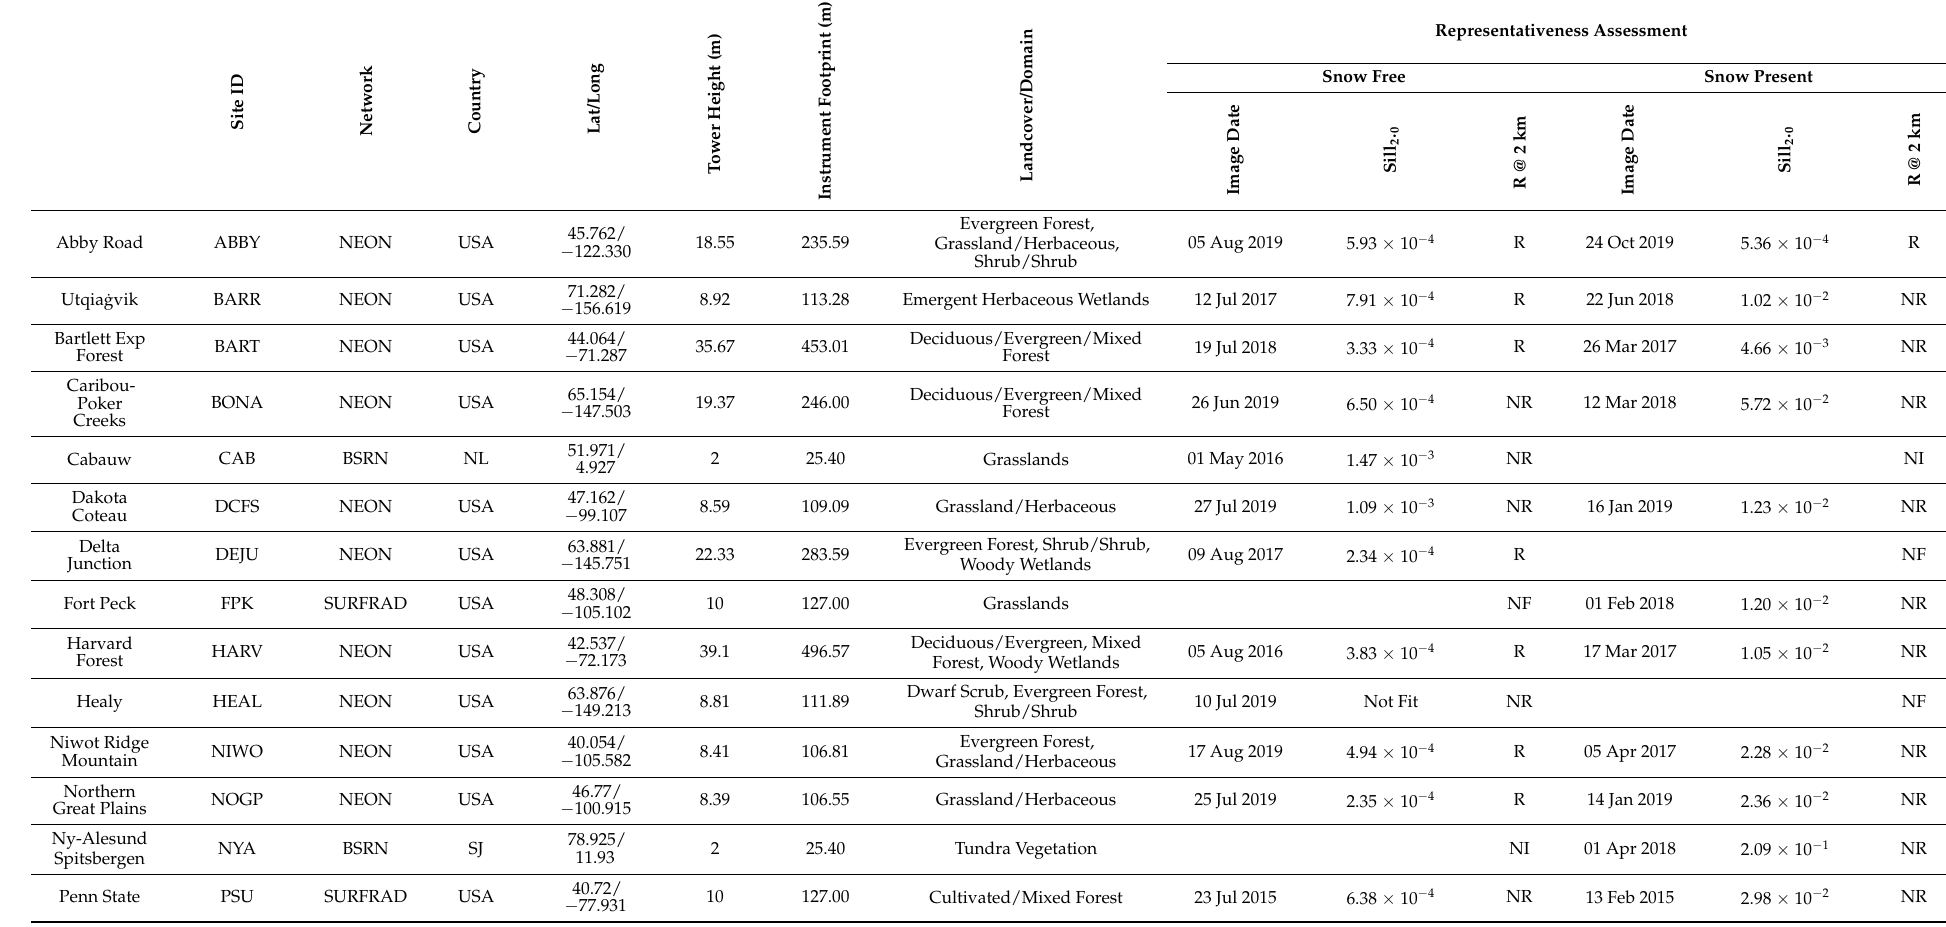
Table 1. The location and specifications of the 26 tower sites used for the comparison of Landsat blue-sky albedo with ground measured tower data. The representative assessment within the 2 km subset for both snow-free and snow-covered imagery is shown in the last six columns with R = Representative, NR = Not Representative, NF = Model was Not Fit indicating the variogram never reached an asymptote on any available imagery for the targeted time period and NI are cases in which No Imagery was available for